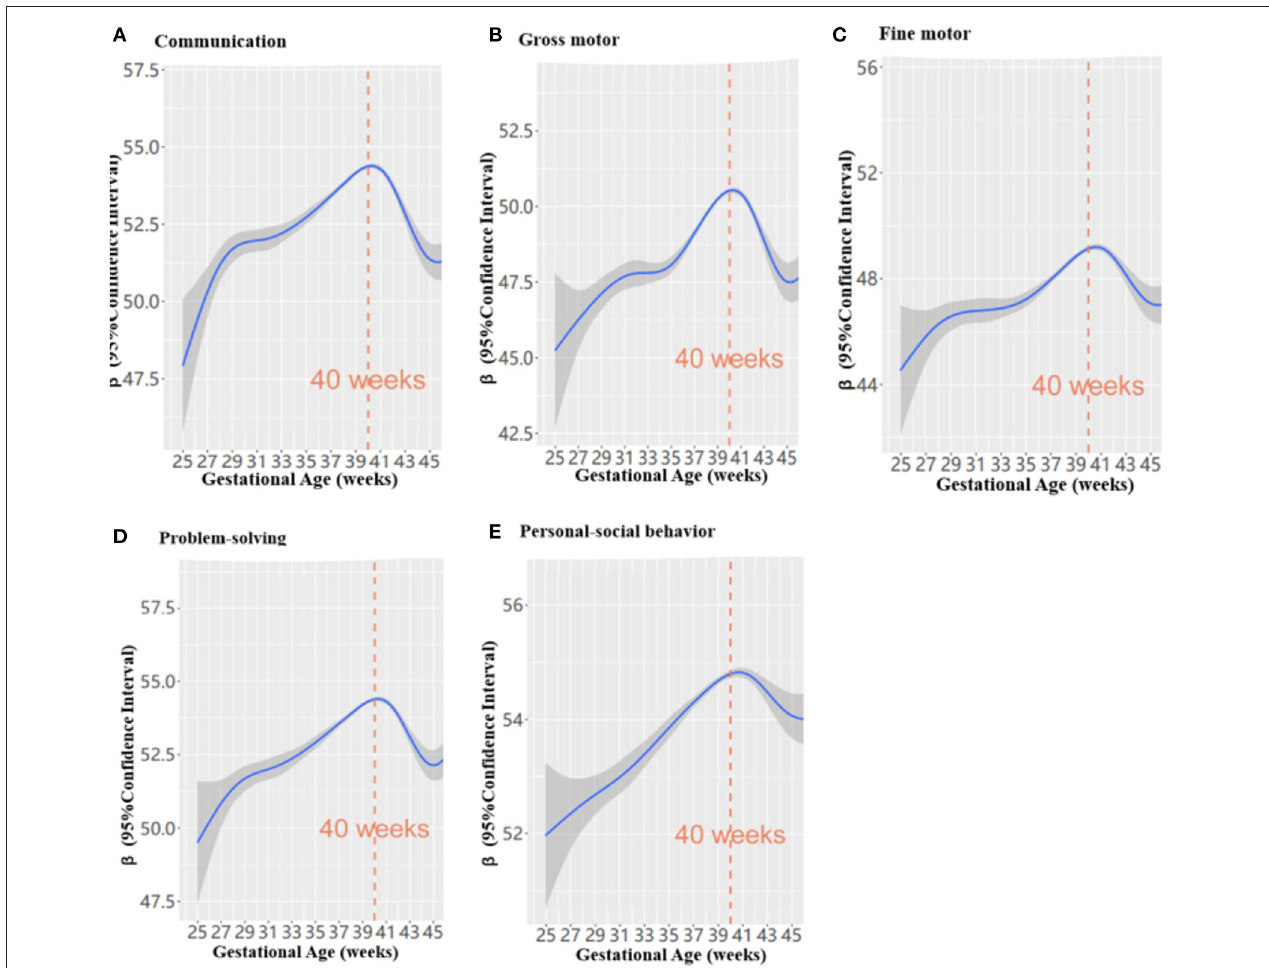
FIGURE 2 | The non-liner relationship between gestational weeks and ASQ-3 scores in preschoolers using a generalized additive mixed model ( n = 137 530); (A–E) refers to different domains.